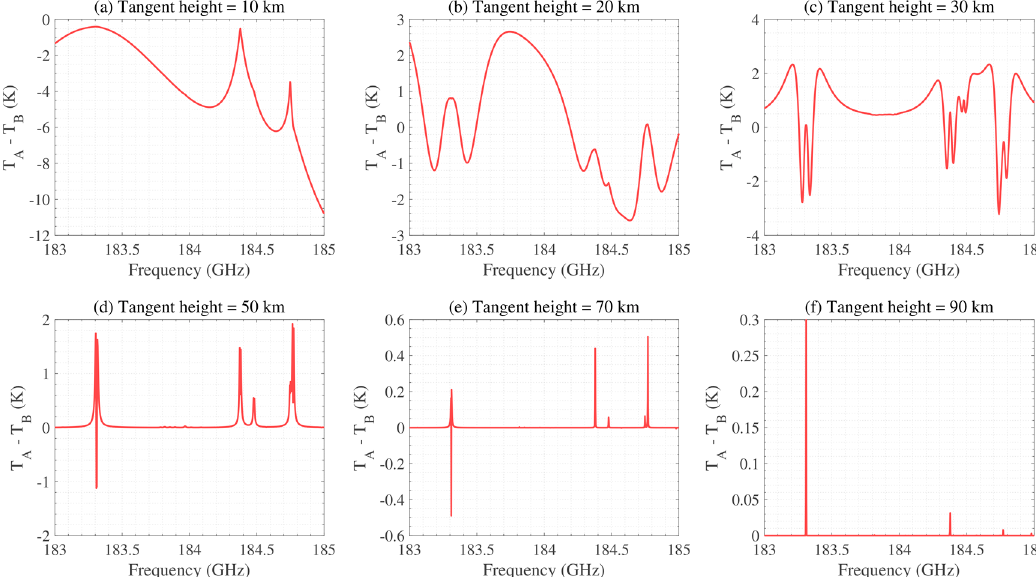
− T at various tangent height measured by B A